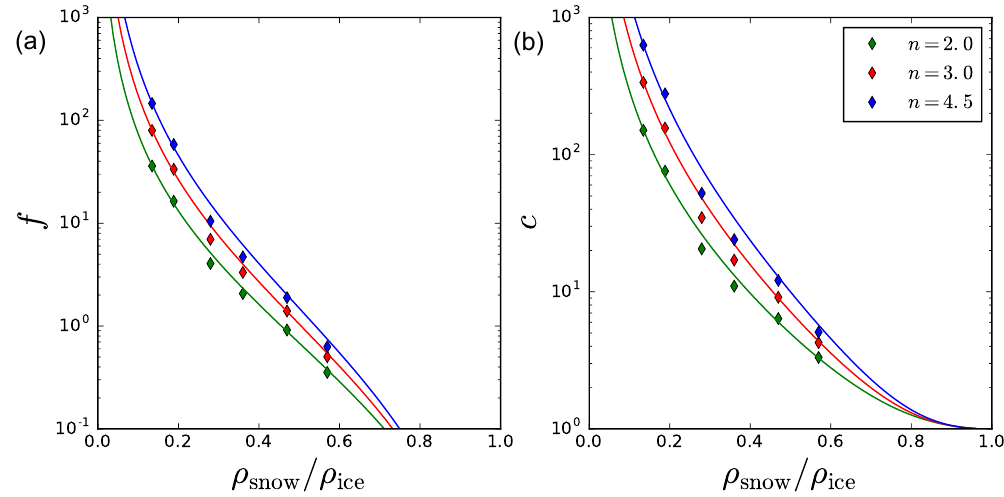
Figure 6. Evolution of the Abouaf coefficients f and c (numerical results as diamond points; functions corresponding to Eq. 29 as solid lines) with respect to snow relative density for different n